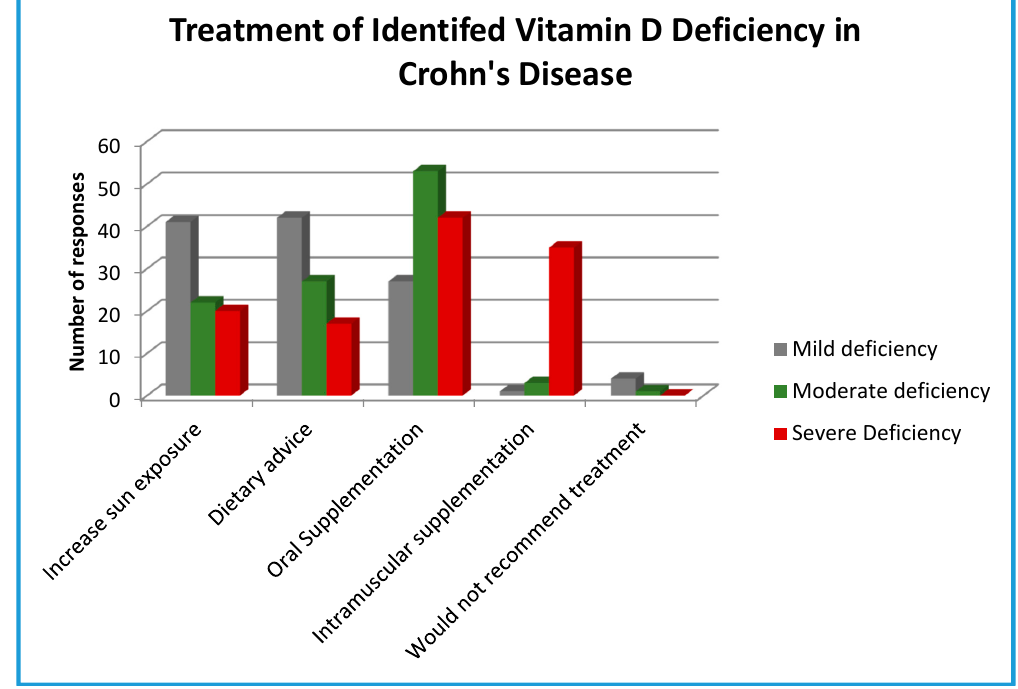
Figure 1. Treatment of identified vitamin D deficiency in Crohn’s disease. Vitamin D deficiency was classified as mild (35–49 nmol/L, moderate (15–34 nmol/L), and severe (<15 noml/L) in the survey.